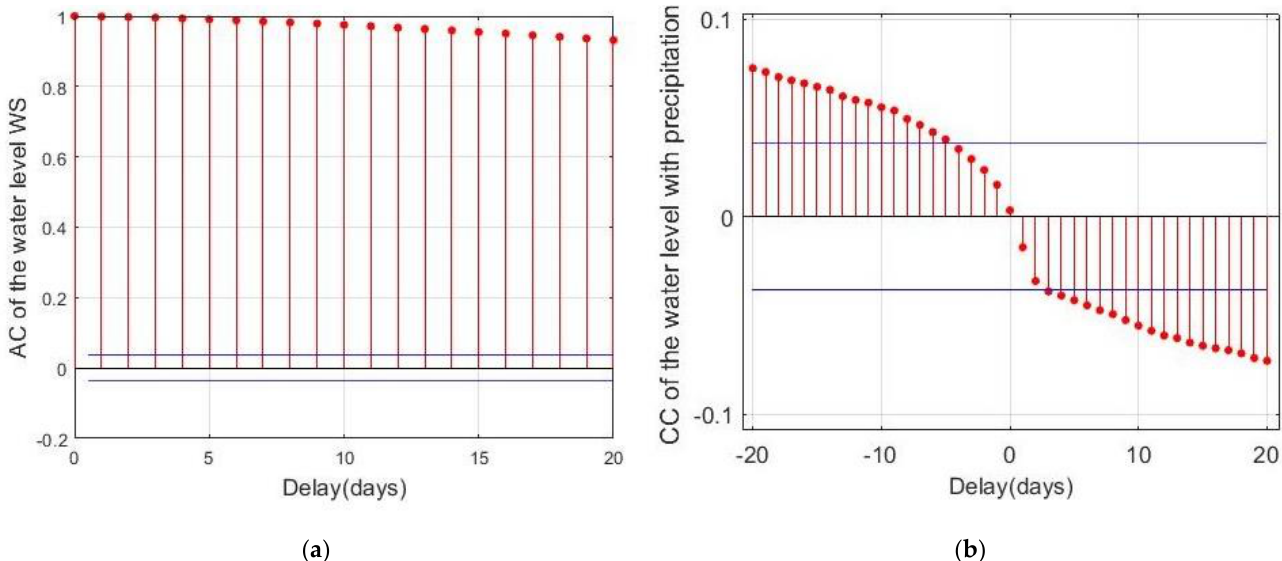
Figure 5. Water level autocorrelation ( a ) and rainfall cross-correlation with P68 ( b ). Symbology: AC = Autocorrelation, WS = with seasonality, CC = cross-correlation.